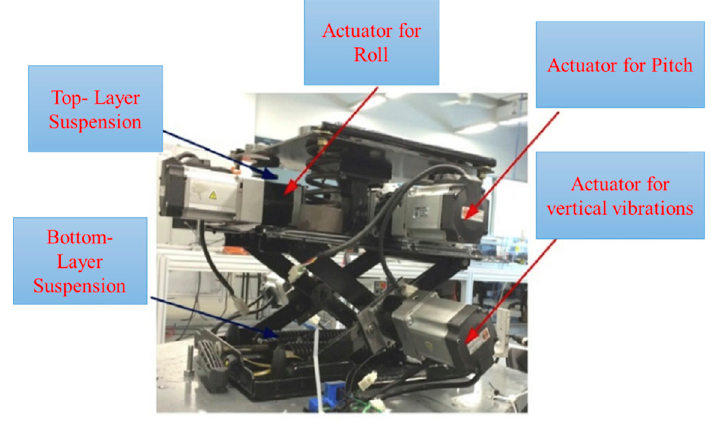
Figure 18. The prototype of multiple-DOF seat suspension [53].